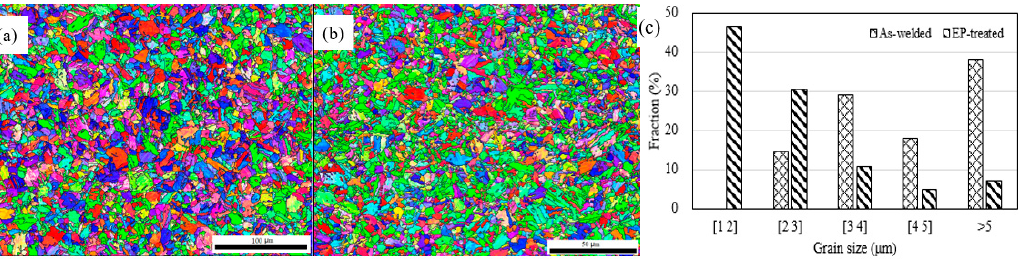
Figure 7. The ( a ) as-welded and ( b ) EP-treated microstructures, and ( c ) grain size distributions of ( a , b ). The strength increment ∆ σ G , due to grain refinement and matrix evolution, can be calculated as follows: